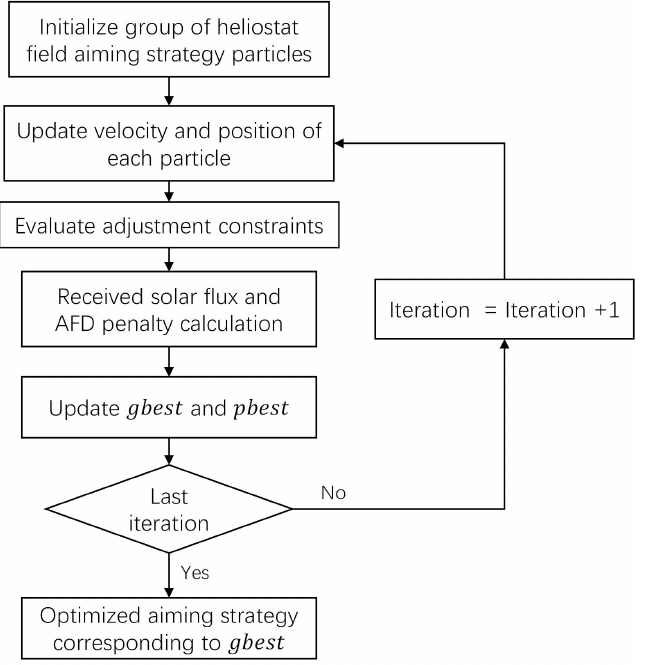
Figure 4. A flowchart of the aiming strategy optimization based on the PSO